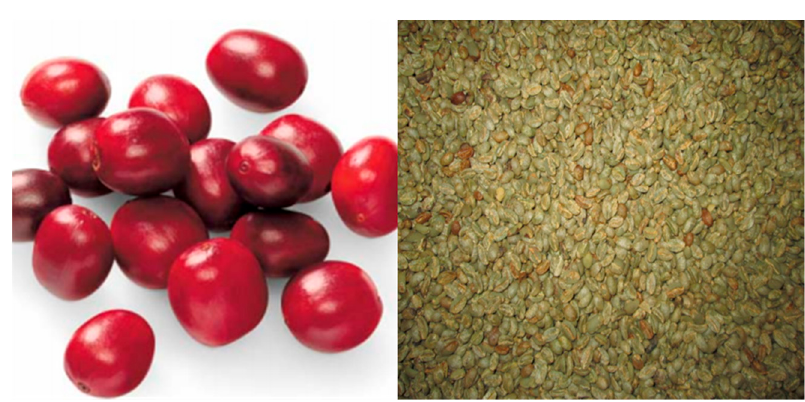
Figure 3. Green coffee bean. Table 1. Characteristics of commercial enzyme preparations used during mashing.